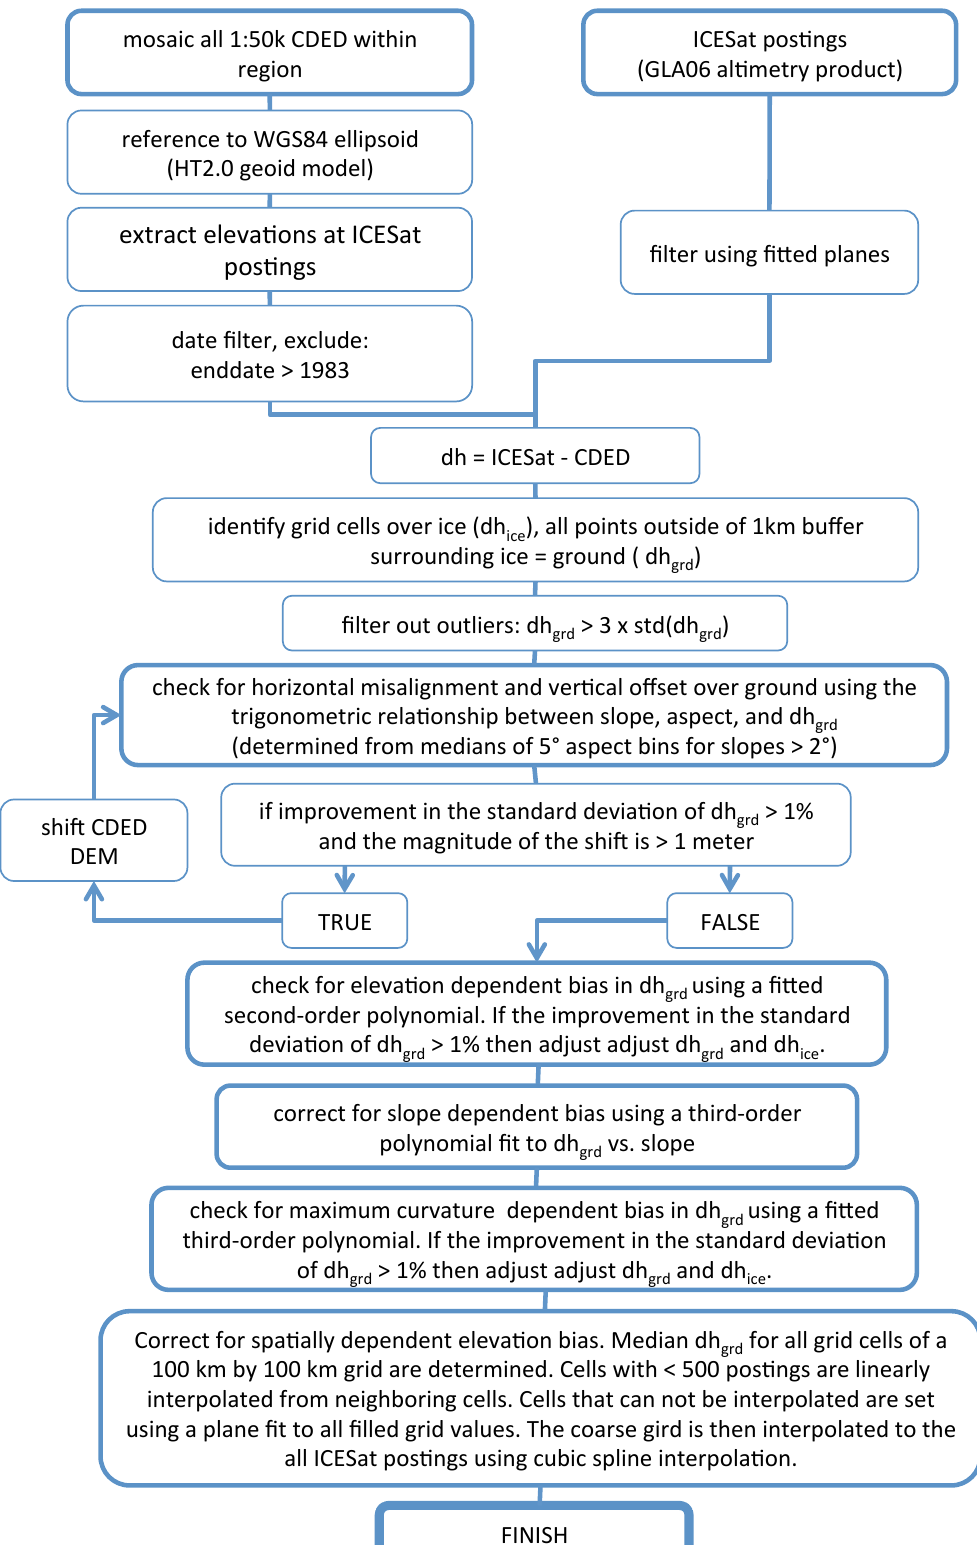
Fig. A3. Workflow for ICESat-CDED differencing.